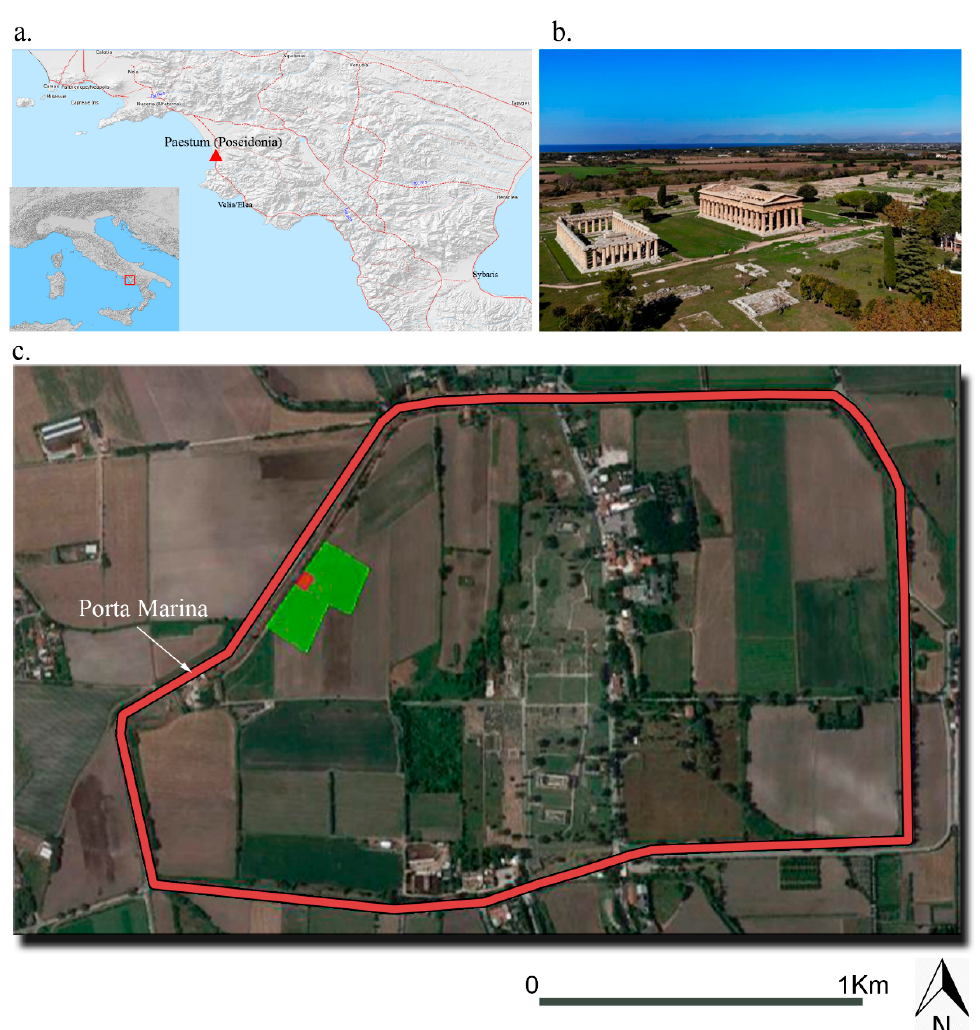
Figure 1. ( a ) Localization of Paestum in the Magna Graecia (Southern Italy); ( b ) Aerial view of the two temples of Neptune and Hera; ( c ) Satellite image of the Paestum (from Google Earth) showing the city wall (in red) and the two investigated areas (in green by magnetometry (MAG) and red by ground penetrating radar (GPR)).